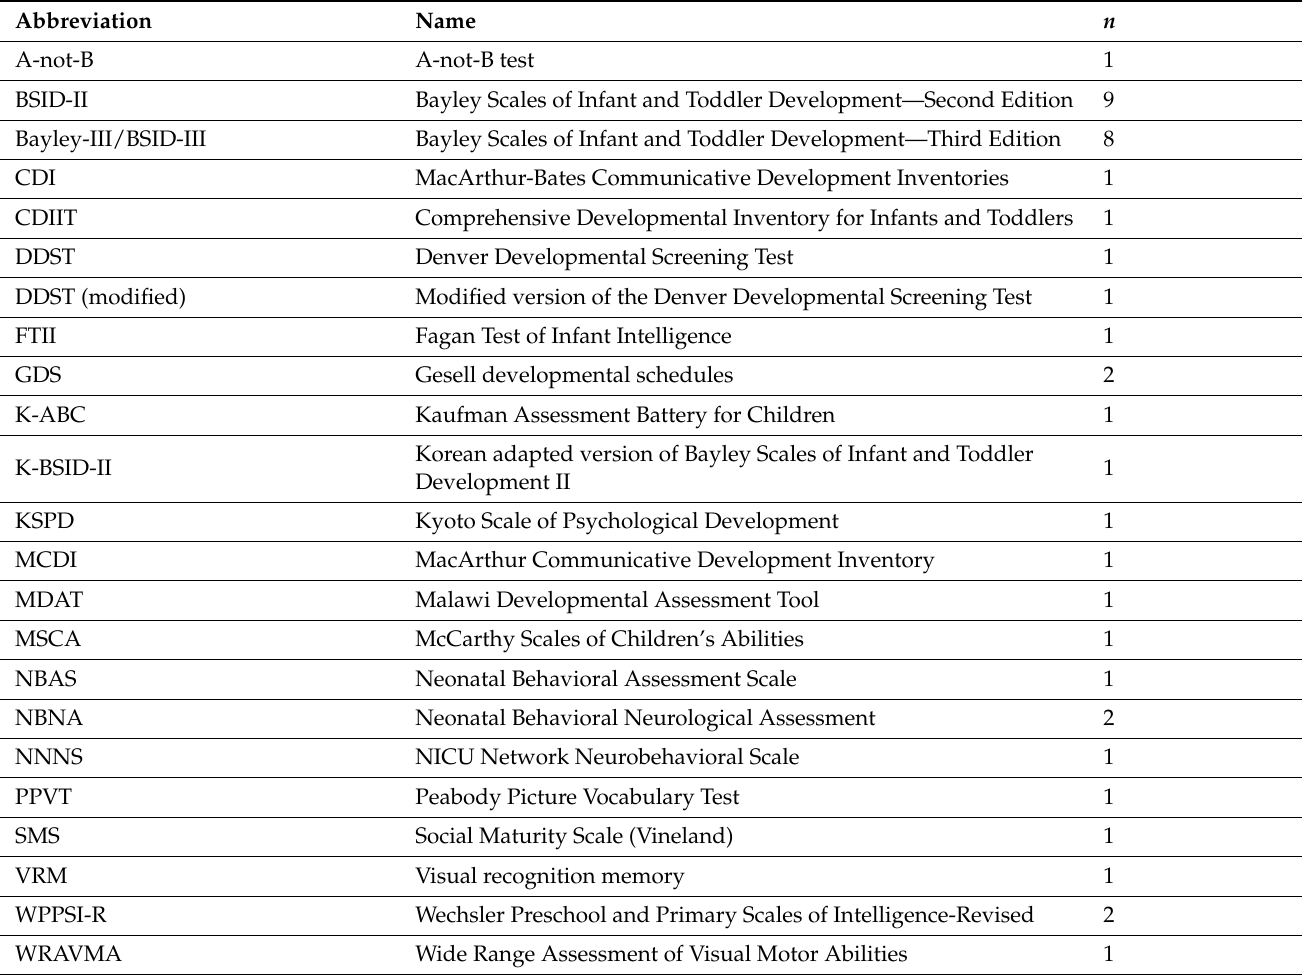
Table 2. Measures of neurodevelopmental functioning in the included